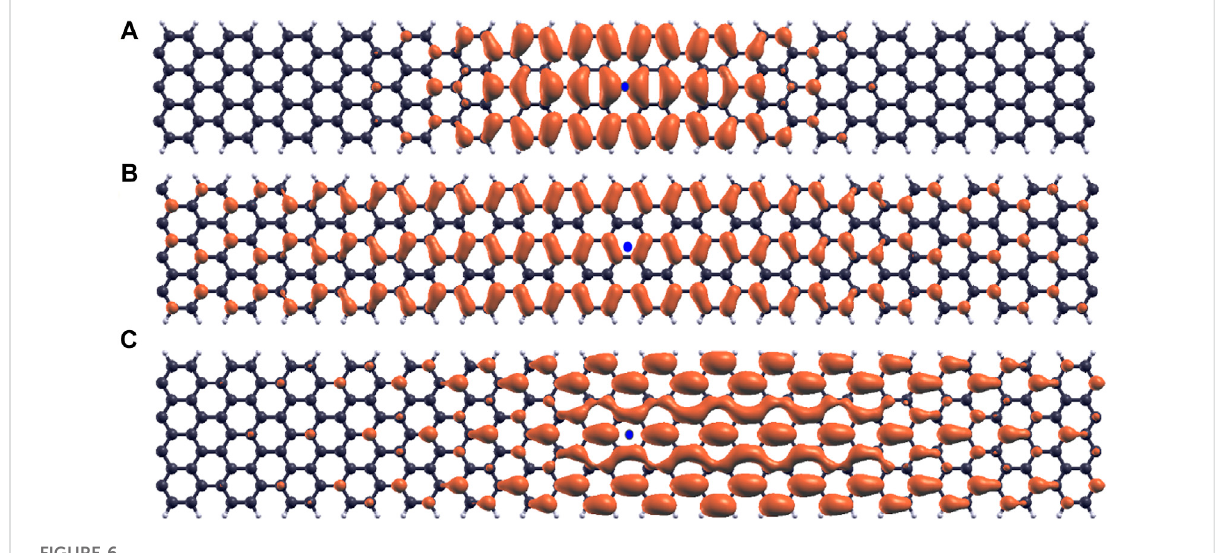
FIGURE 6 Excitonwavefunctions. (A) E 1,1 excitonwavefunctionsfor7-AGNR. (B) E 1,1 excitonwavefunctionsfor8-AGNR. (C) E 1,1 excitonwavefunctionsfor 9-AGNR.